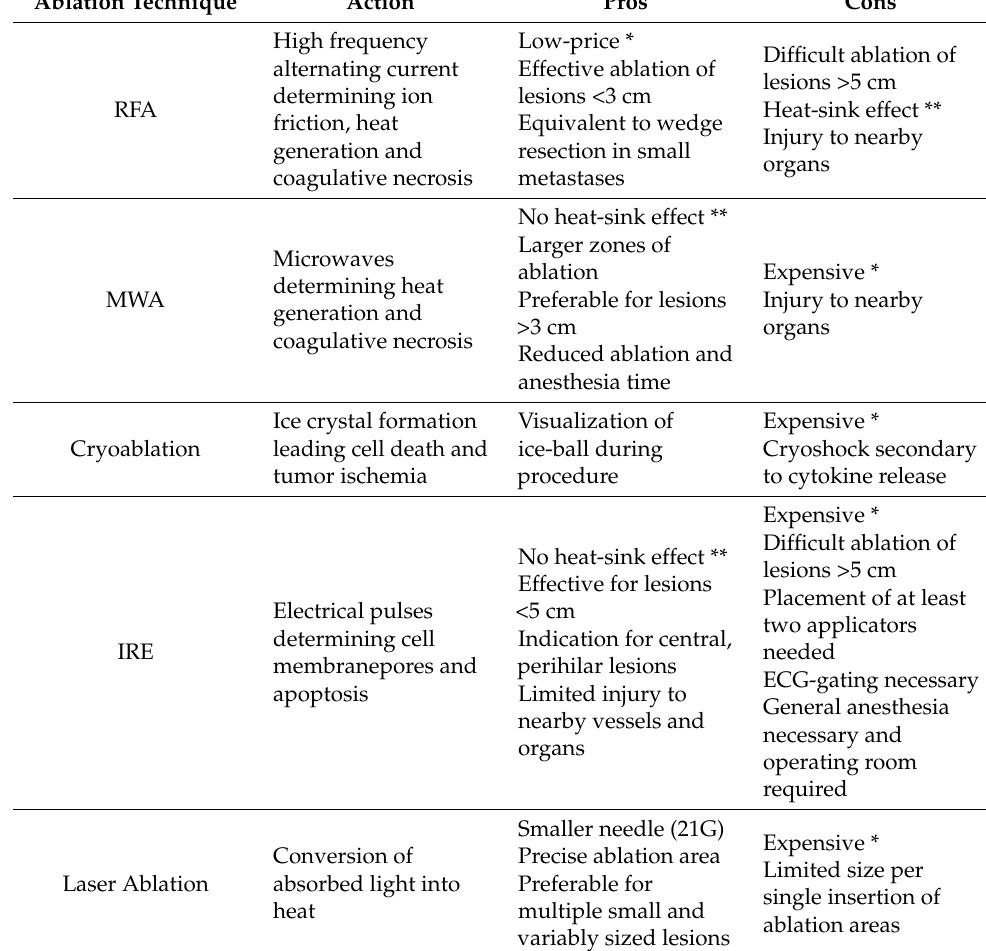
Table 1. Mechanism of actions and pros and cons of all different ablations